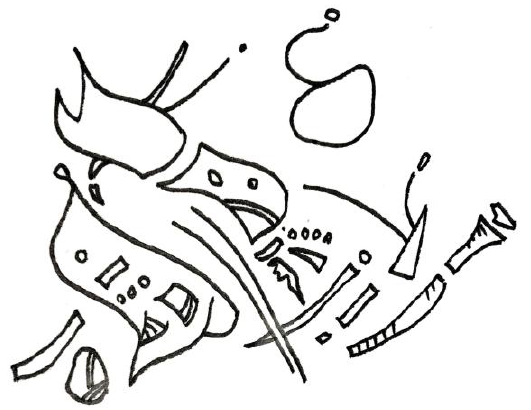
Figure 2. Illustration of Kandinsky’s theory of point line and surface [5].